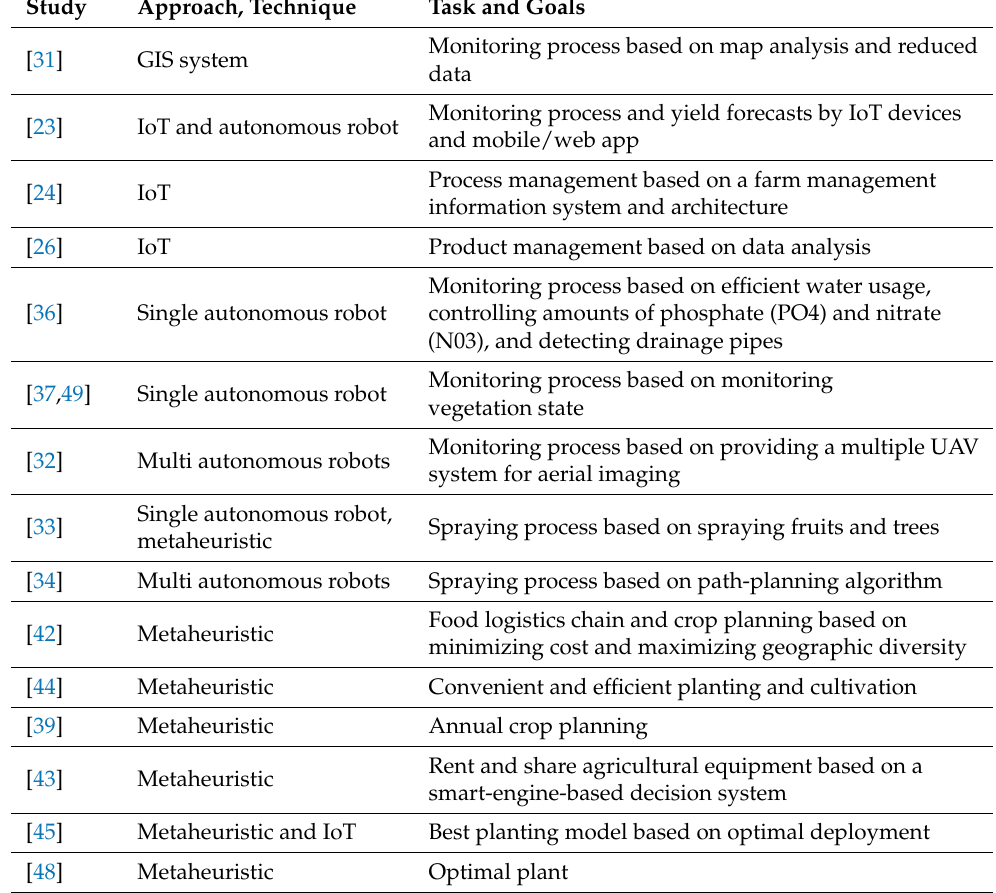
Table 1. Characterization of current studies in the